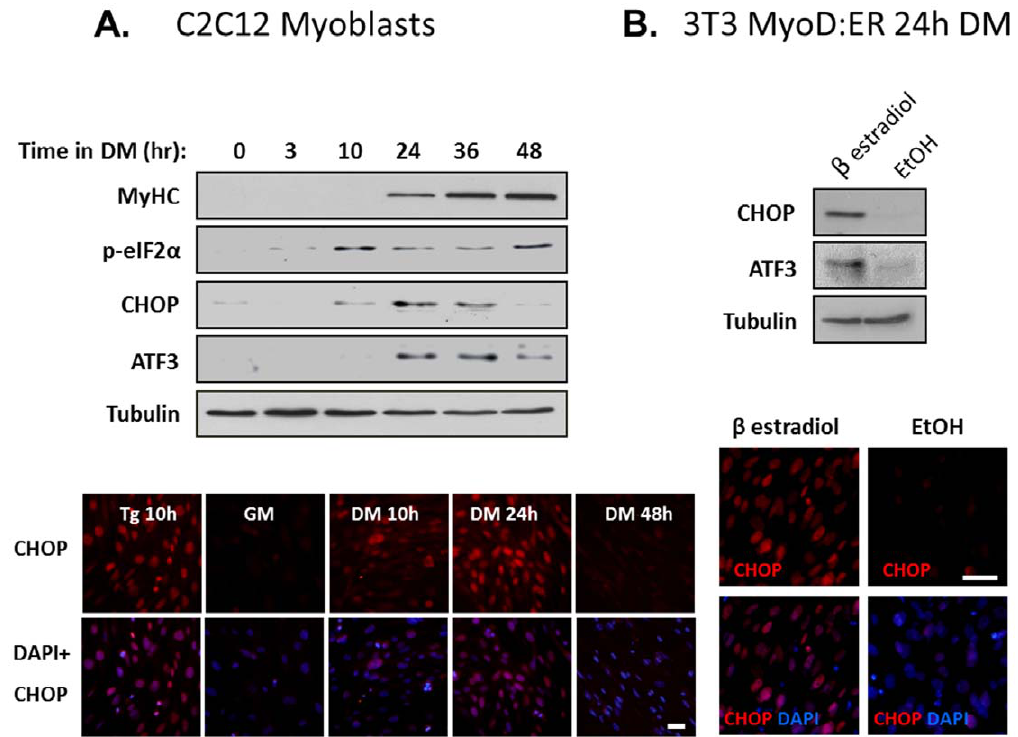
Figure 1. Transient expression of stress response proteins during myoblast differentiation. (A) C2C12 myoblasts were differentiated in DM and proteins were extracted at different time points as indicated. Protein were separated and analyzed by Western blotting (Upper panel). In another experiment C2C12 myoblasts were differentiated as is described. Cells were fixed and analyzed by immunostaining with an antibody to CHOP. CHOP in red, DAPI in blue (Lower panel). Bar, 50 m m. (B) 3T3 MyoD:ER cells were differentiated in DM containing ethanol or b estradiol (0.1 m M) for 24 hours. Proteins were extracted and were analyzed by Western blot with the indicated antibodies (Upper panel). Cells were fixed and were analyzed by immunostaining with an antibody to CHOP. CHOP is red, DAPI in blue (Lower panel). Bar, 50 m